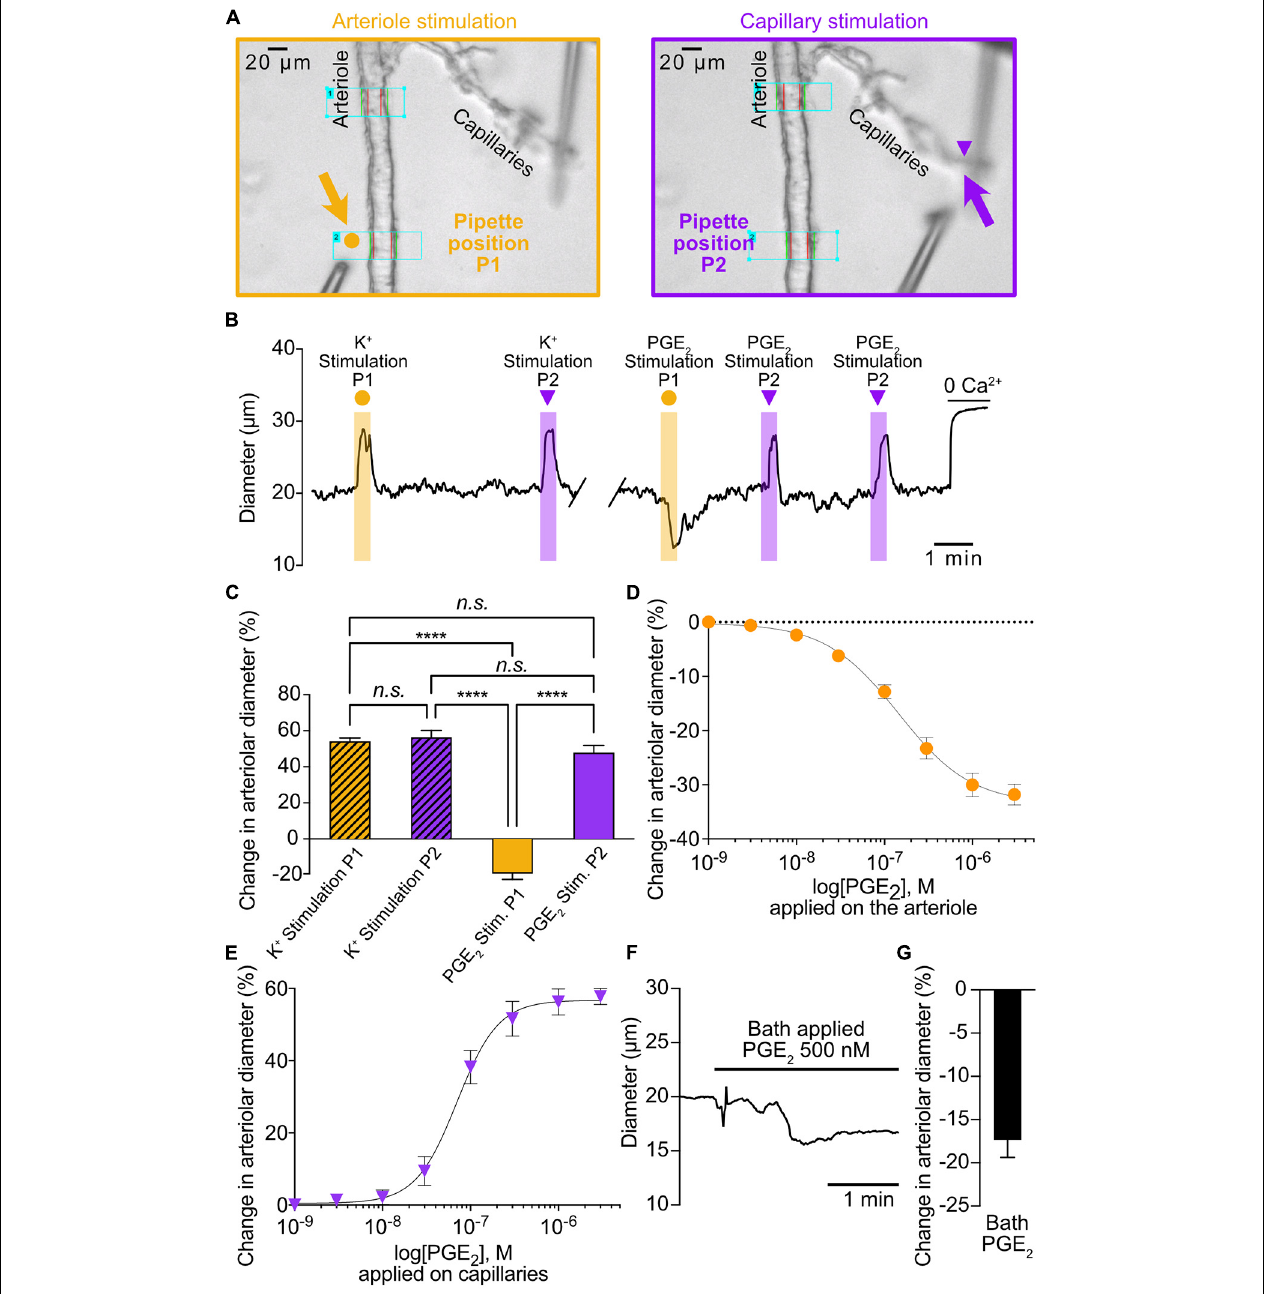
FIGURE 1 | PGE 2 causes upstream arteriolar dilation when applied onto capillaries. (A) Pipette positions for arteriole stimulation (left, 5 orange arrow) and capillary stimulation (right, purple arrow) in CaPA preparations. (B) Representative trace of arteriolar diameter showing effects of pressure ejection of 10 mM K + or 1 µ M PGE 2 onto arteriole (P1, orange dot) and capillaries (P2, purple triangle). (C) Summary data from 6 mice ( n.s. , not significant; **** P < 0.0001, one-way ANOVA, Tukey’s test). (D) Concentration-response curve produced by locally applying PGE 2 to the arteriolar segment over a concentration range of 1 nM to 3 µ M (5 mice). An EC 50 of 145 nM was calculated from the non-linear regression curve. (E) Concentration-response curve produced by locally applying PGE 2 to capillary extremities over a concentration range of 1 nM to 3 µ M (8 mice). An EC 50 of 70 nM was calculated from the non-linear regression curve. (F) Representative trace of arteriolar diameter showing effects of bath application of 500 nM PGE 2 . (G) Summary data from 5 mice.